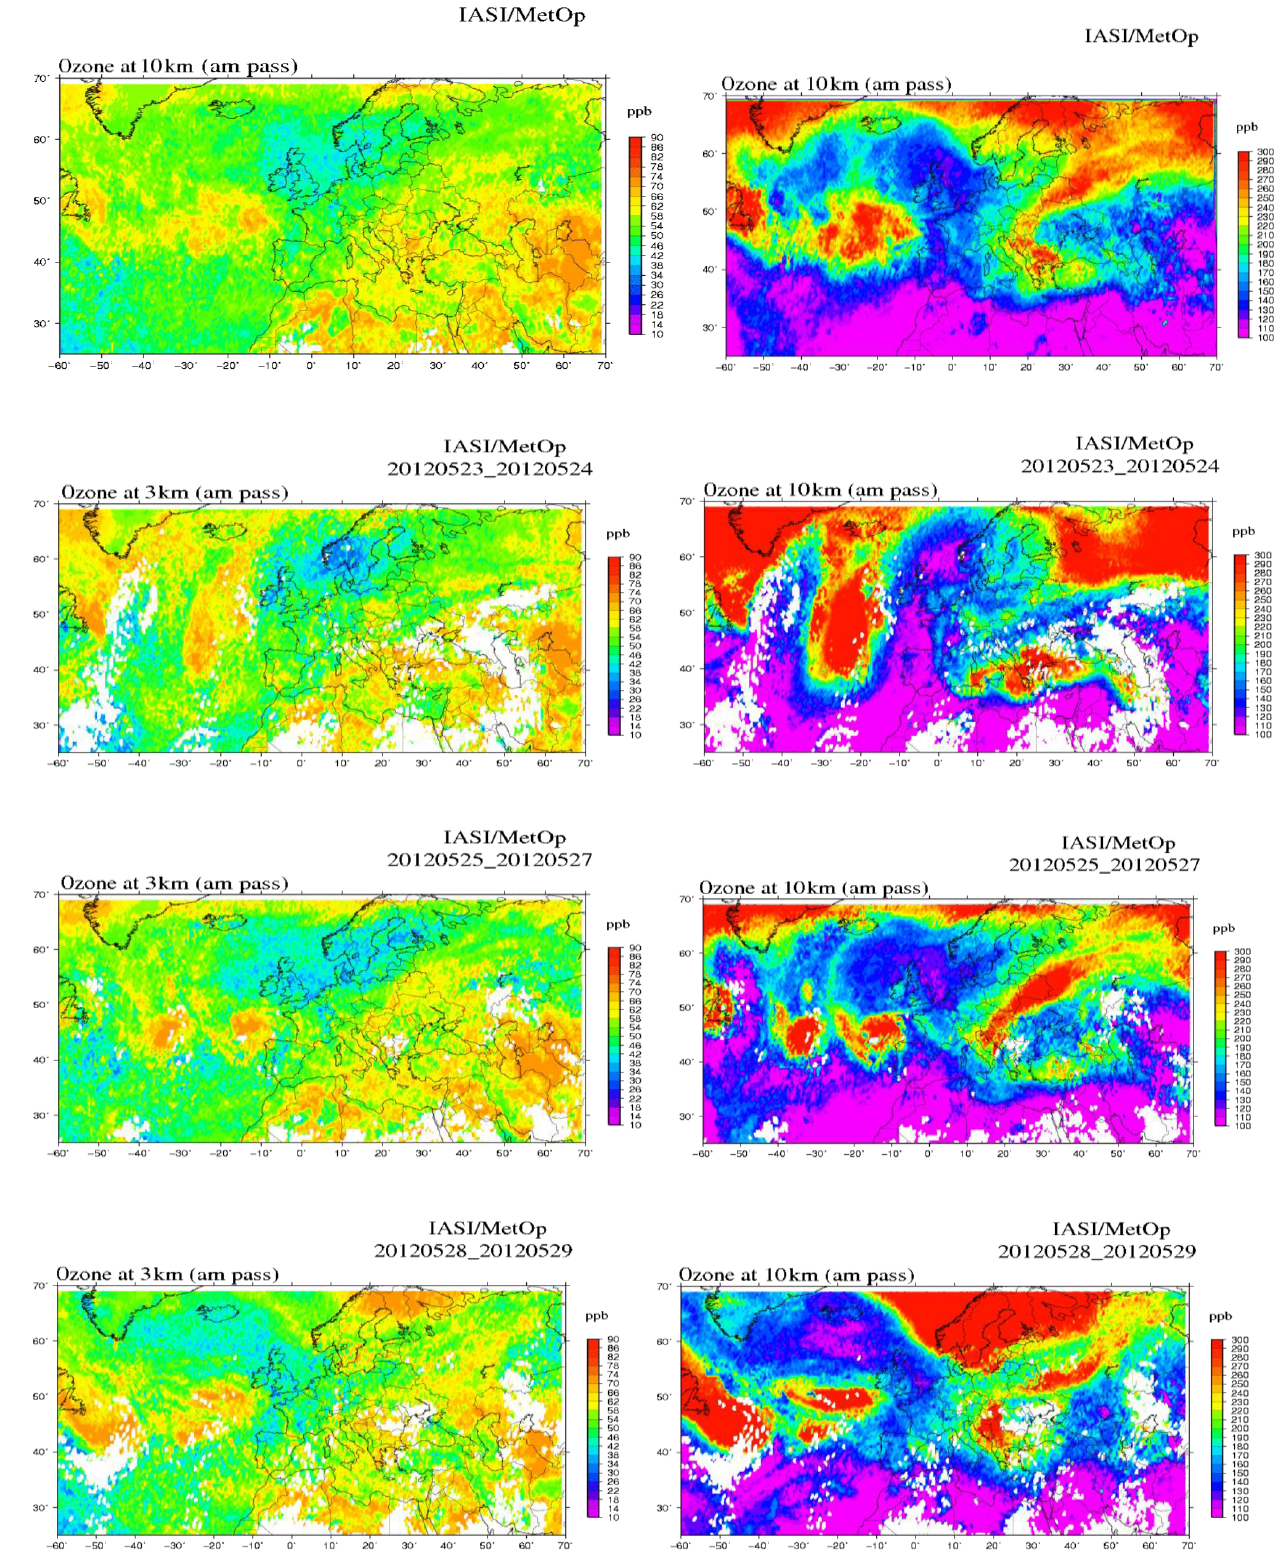
Figure 4. IASI satellite images for ozone concentration at 3km (left column) and 10km (right column) for the episode of 23–29 May 2012. Starting from the top: 23–29, 23–24, 25–27 and 28–29